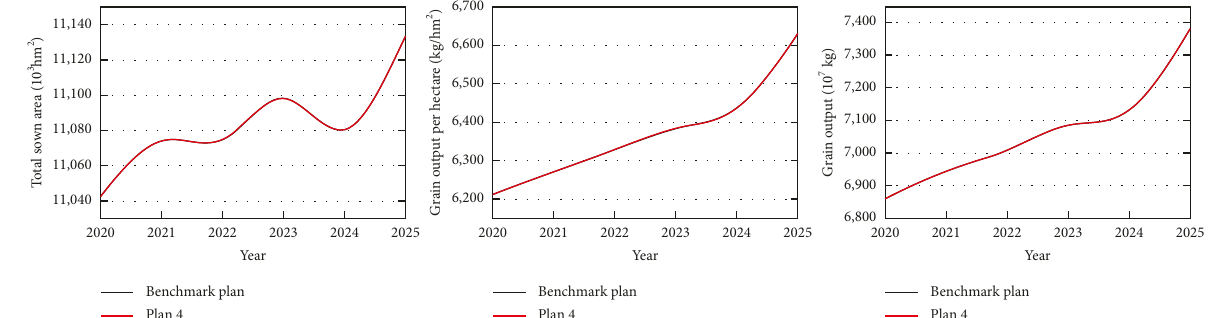
Figure 6: Comparison of simulation results between Benchmark plan and Plan 4.